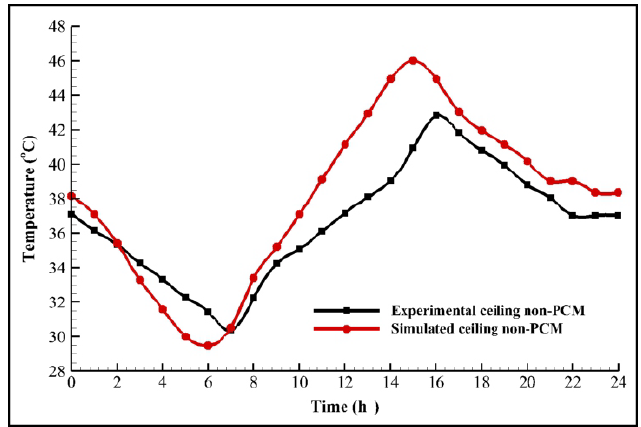
Figure 20. Experimental and simulated temperature of the PCM integrated roof.